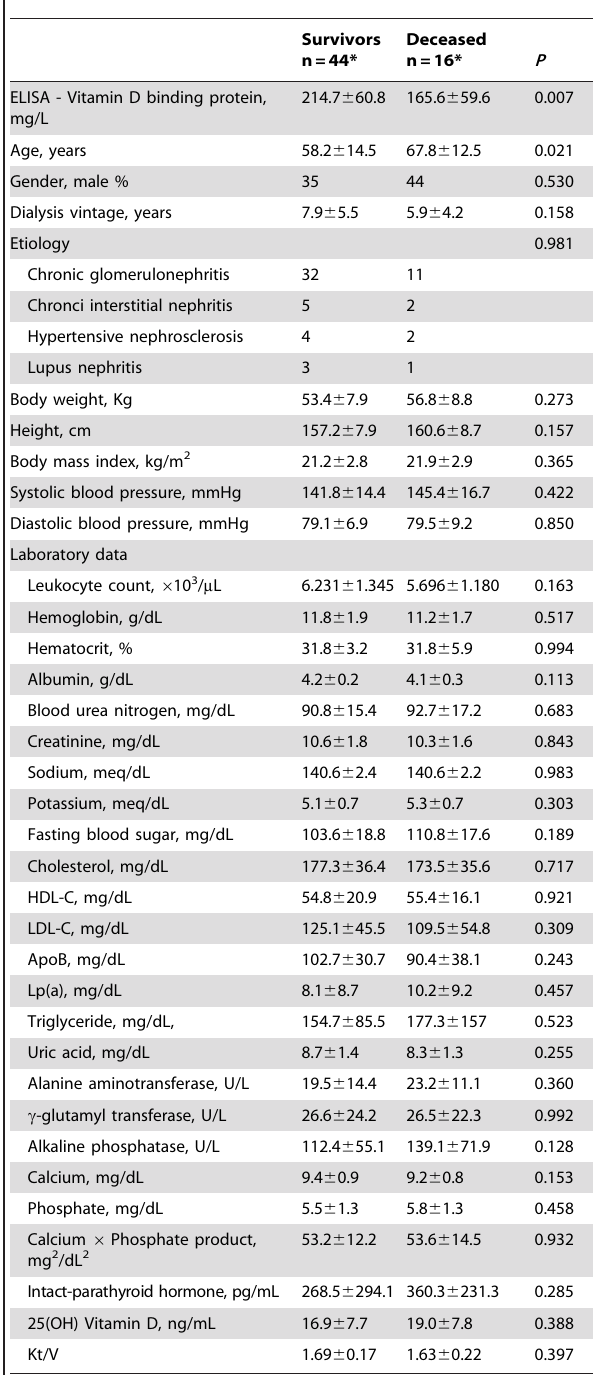
Table 3. Comparison between the surviving and deceased HD patients in a four-year follow-up.